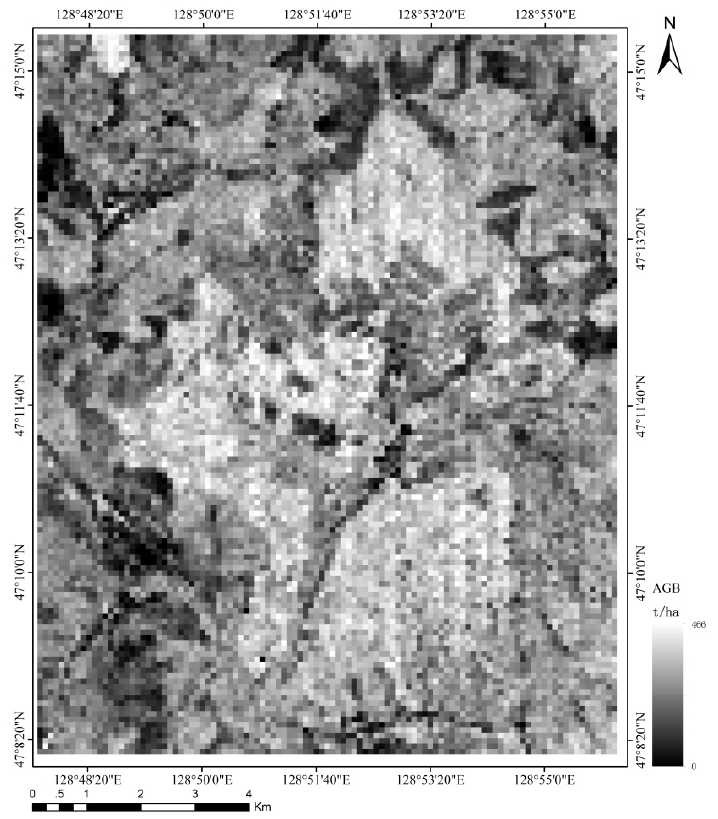
Figure 6. SVR-predicted AGB map derived by FOTO indices in the study area (242.67 ± 87.78 t/ha).